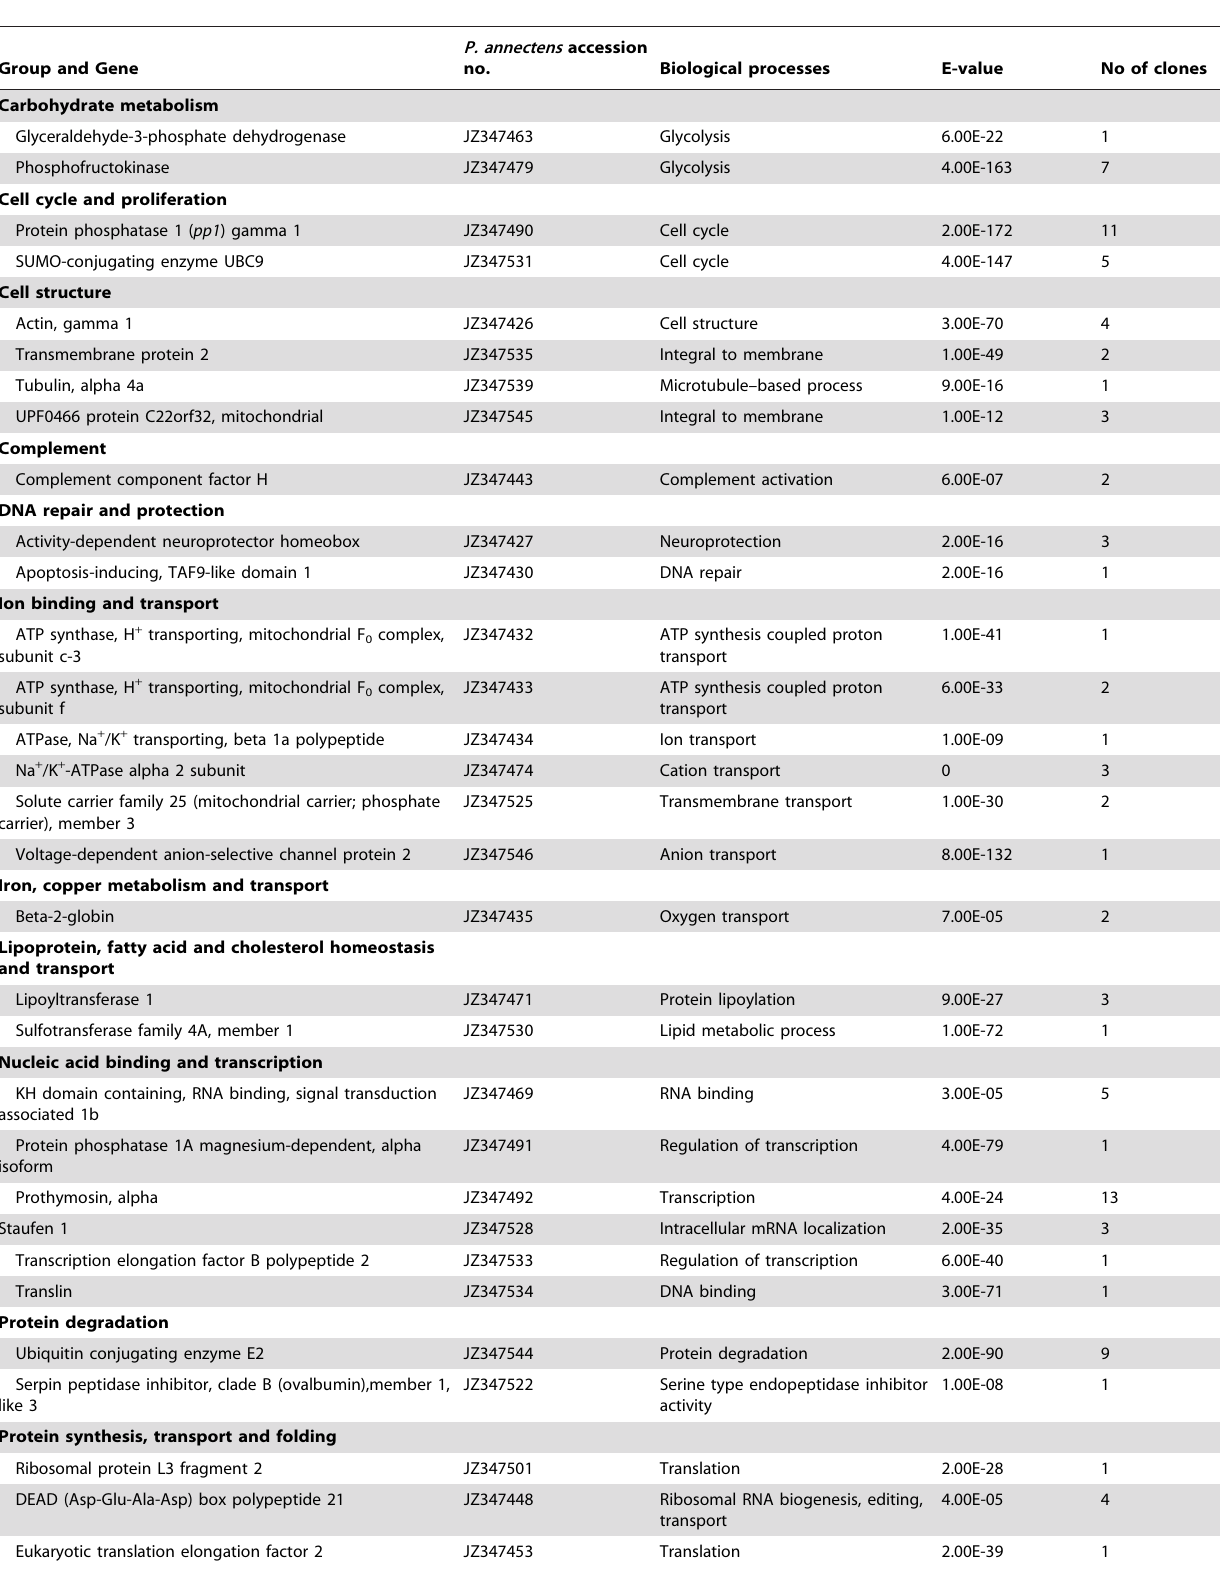
Table 3. Known transcripts found in the reverse library (down-regulation) obtained by suppression subtractive hybridization PCR from the brain of Protopterus annectens aestivated for 6 days in air with fish kept in freshwater as the reference for comparison.